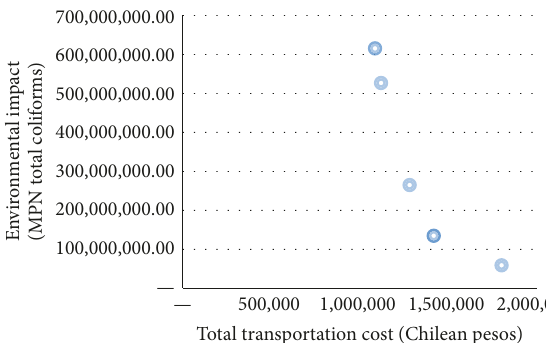
Figure 6: Pareto front obtained using weighted sum method.